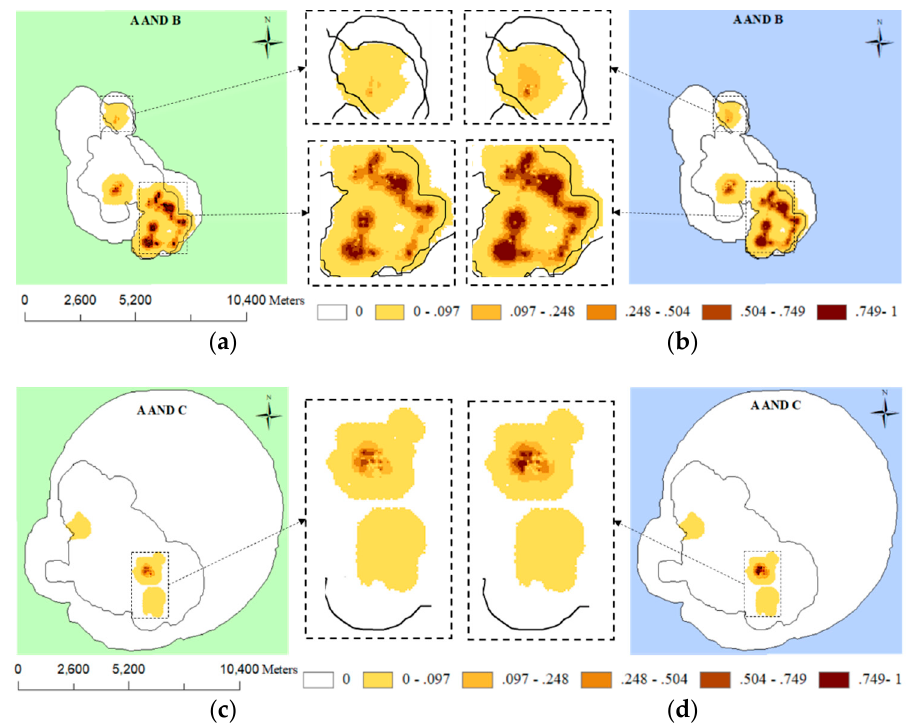
Figure 5. Encounter probability maps with the distance-decay coefficient (DDC) ( a , c ) and without the DDC ( b , d ).